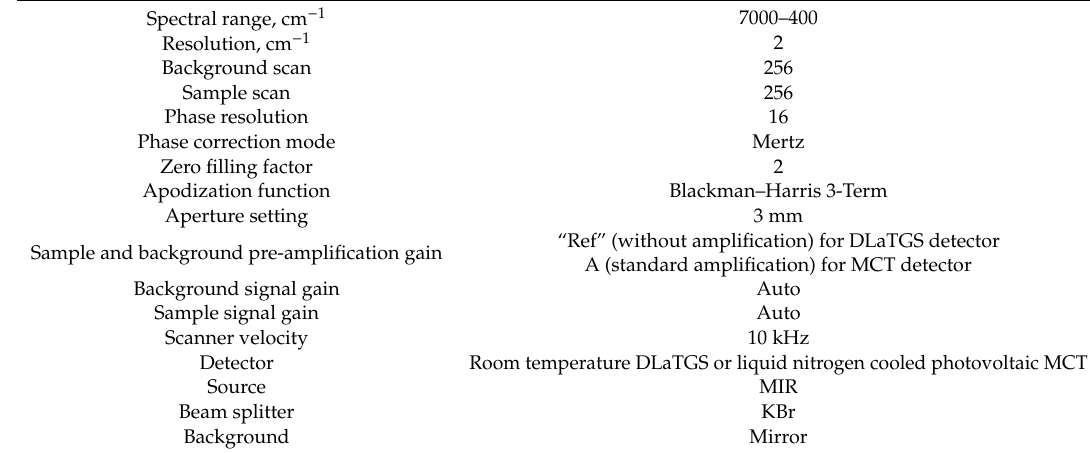
Table 4. Parameters of recording ND spectra in the near to middle IR by